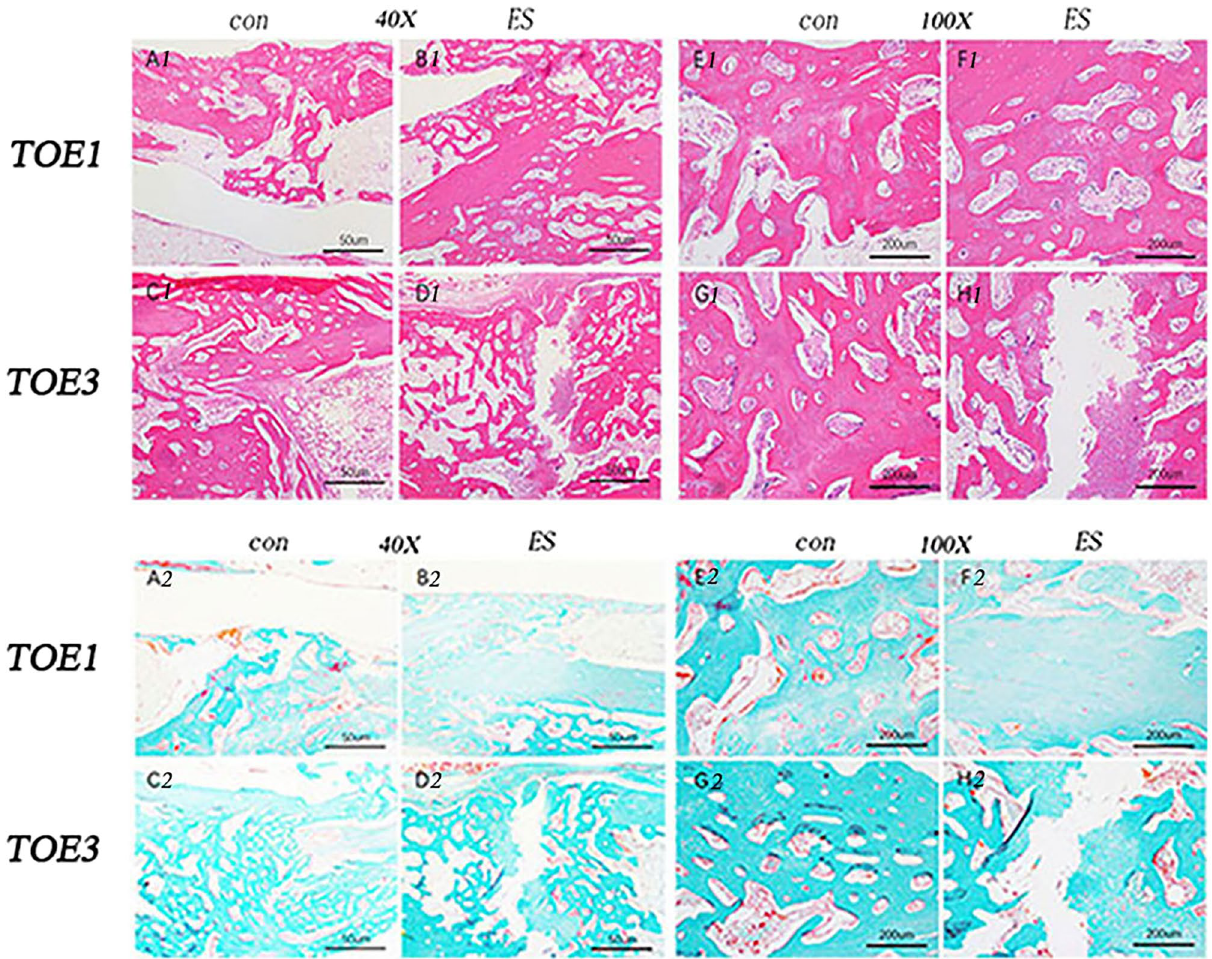
Figure 6. Typical tissue images stained with haematoxylin–eosin (HE) and Goldner’s trichrome staining 1 month after surgery. HE staining of bone tissue in controls A1, C1, E1, and G1 and B1 and F1 at the negative electrode connection shows the formation of numerous trabeculae with no gaps between the tissues. Bone tissue D1 and H1 at the positive electrode connection shows limited trabecular formation with some areas showing neither trabeculae nor osteocytes. Goldner staining of bone tissue in controls A2, C2, E2, and G2 and at the negative electrode connections B2 and F2 shows large areas of green mineralised bone that is connected in sheets with only a small amount of bone-like material with no gap between the tissues. Bone tissue at the positive electrode junction D2 and H2 shows a large area of red osteoid at the positive electrode fracture with very little green mineralised bone (N ≥